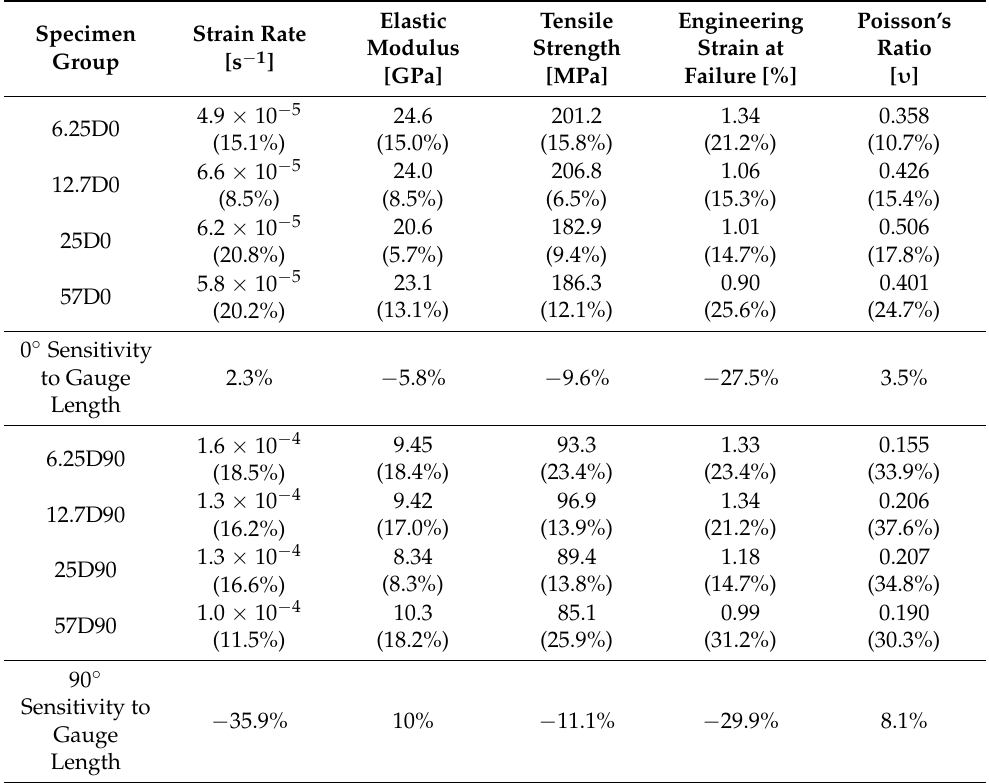
Table 4. Summary of quasi-static uniaxial tensile test results (coefficient of variation in